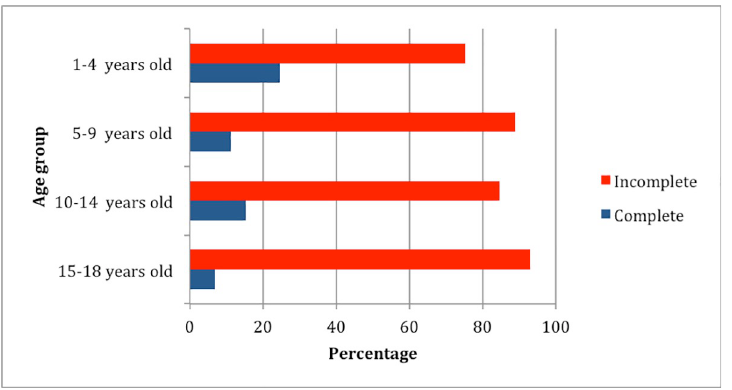
Fig 2. The association between age groups and immunization